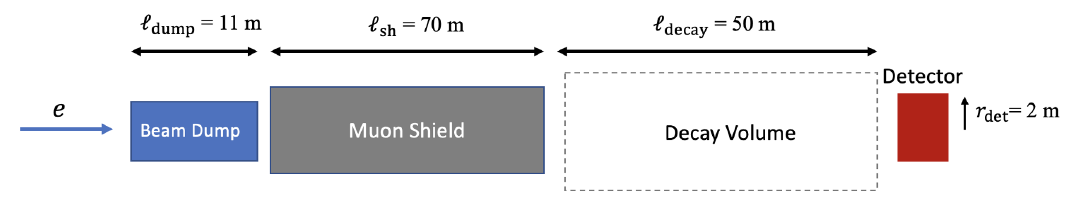
Figure 1 . Schematic layout of the beam dump experiment for the ILC. A similar experiment can be designed for other e + e − colliders as C 3 , CLIC, FCC-ee, and